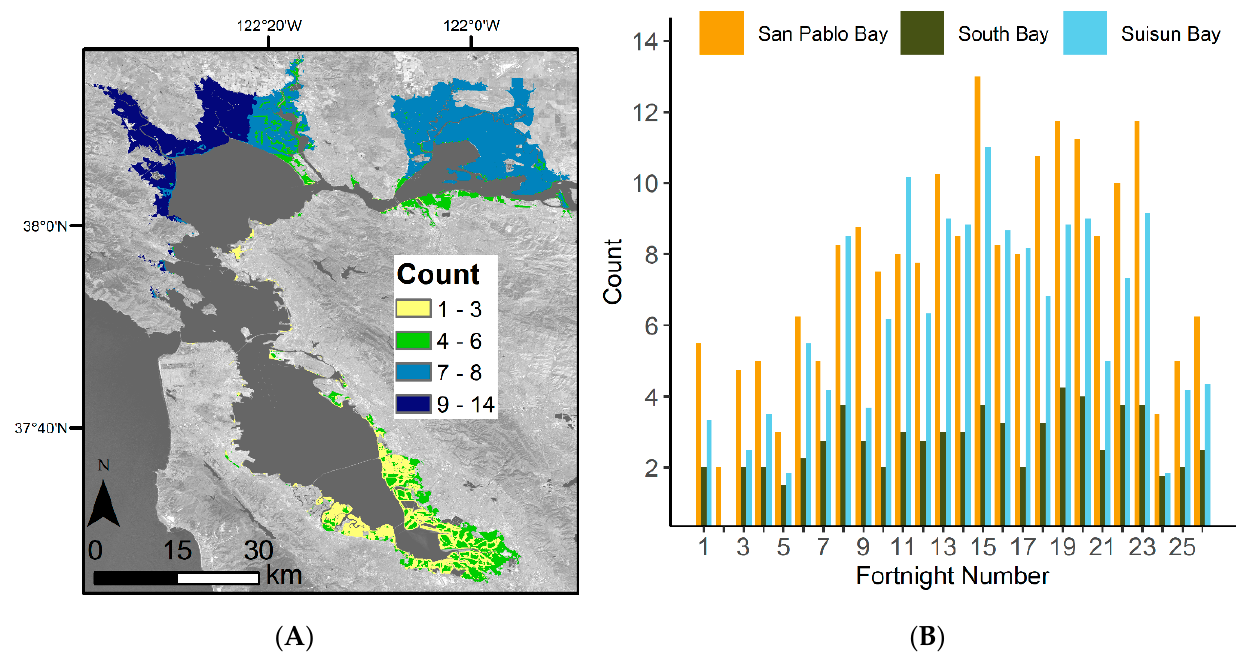
Figure 3. Number of Landsat scenes used to generate EVI history. ( A ) The average number (count) of Landsat scenes used to generate average EVI history for each fortnight within the Bay Area. The numbers of scenes for each of the 26 fortnights were averaged together to generate one mean count map. Basemap: Landsat 8 band 7 (SWIR 2), U.S. Geological Survey. ( B ) Average number of Landsat scenes used within the 14 model development areas for each time step. The counts are further broken up into region, San Pablo Bay, South Bay, and Suisun Bay.